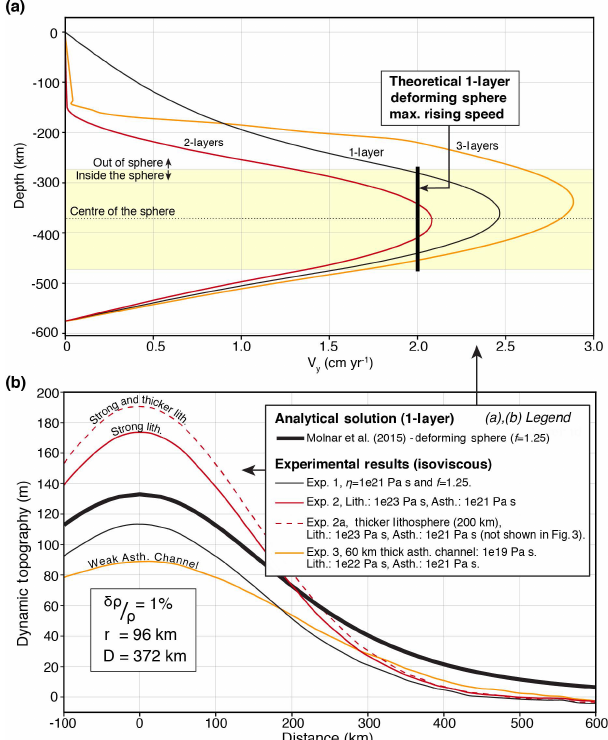
Figure 4. (a) Vertical velocity profiles ( V y ) along the centre, and (b) analytical solution and numerical modelling results showing dy- namic topography induced by a sphere of temperature anomaly in the mantle ( r = 96km, δρ/ρ = 1%). The misfit between the numer- ical model for R = 1 and the analytical solution is due to finite space in the numerical model compared to semi-infinite space assumed in the analytical solution (Morgan,